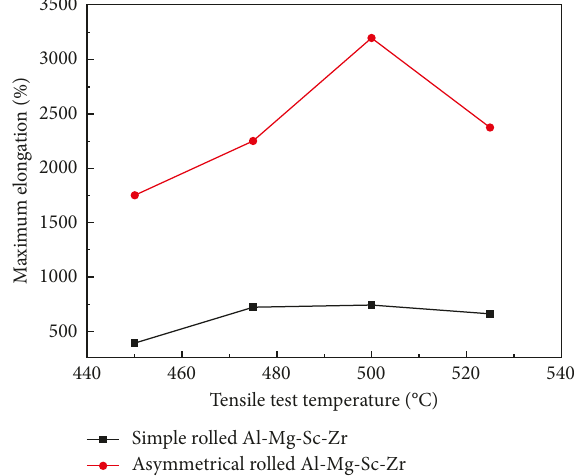
Figure 9: Comparison of maximum elongations of the two Al-Mg- Mn-Sc-Zr alloys under 4 tested temperatures of all tested stain